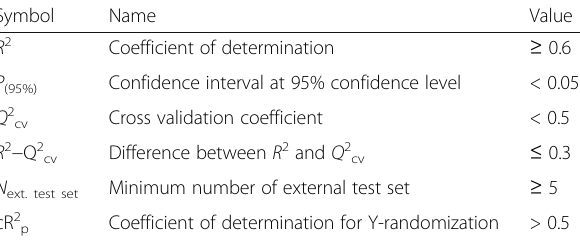
aminoquinoline hybrids and their antimalarial activities